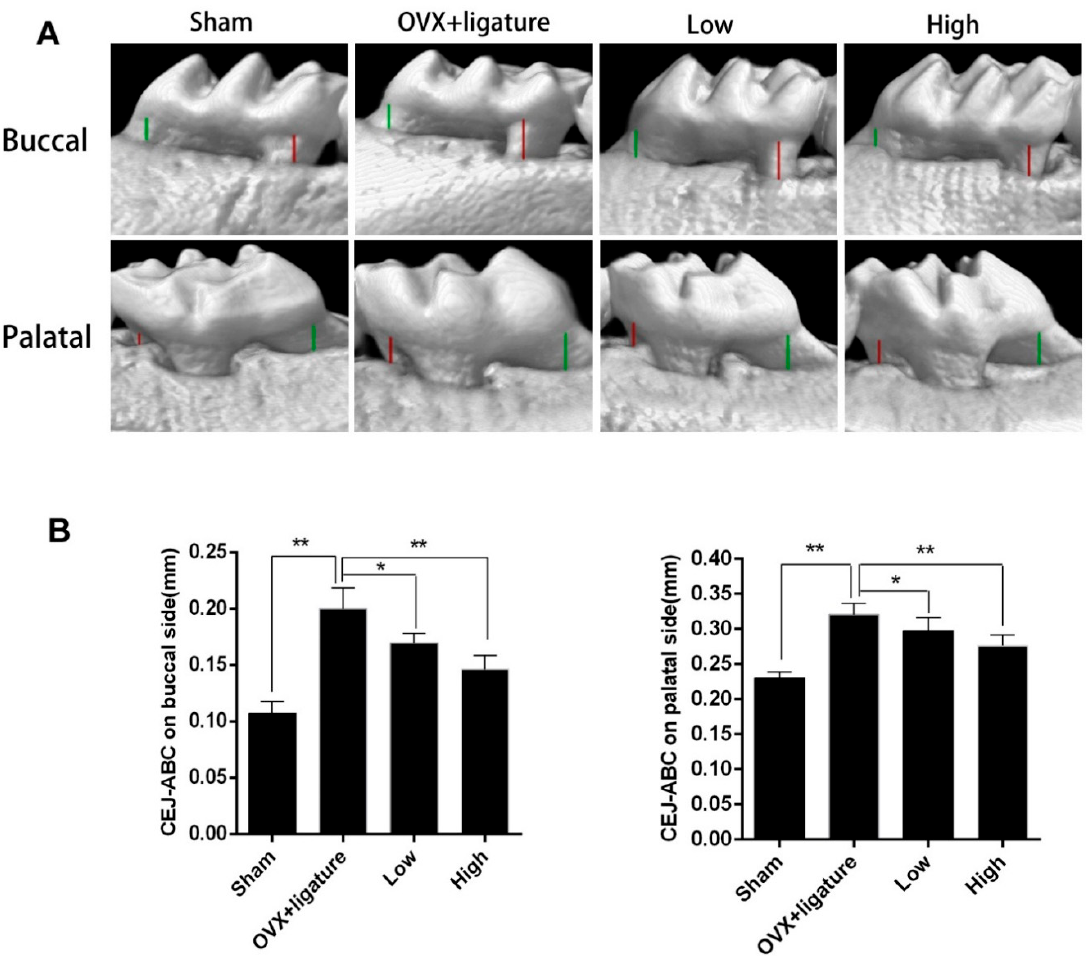
Figure 2. Effect of myricetin on maxilla of cemento-enamel junction (CEJ) to alveolar bone crest (ABC). ( A ) Buccal and palatal sides of maxilla showing alveolar bone loss (ABL, colored lines) was measured from CEJ to ABC at 4 points: mesiobuccal (MB, red), mesiolingual (ML, red), distobuccal (DB, green), and distolingual (DL, green) regions for first maxillary molar (M1); ( B ) Analysis of CEJ-ABC linear distance after myricetin or placebo treatment; * p < 0.05, ** p < 0.017; n = 6.